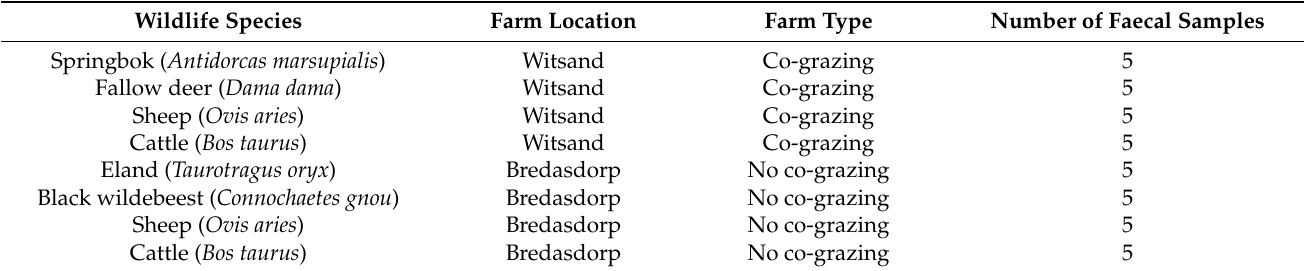
Table 2. Details of the wildlife and livestock samples used in this